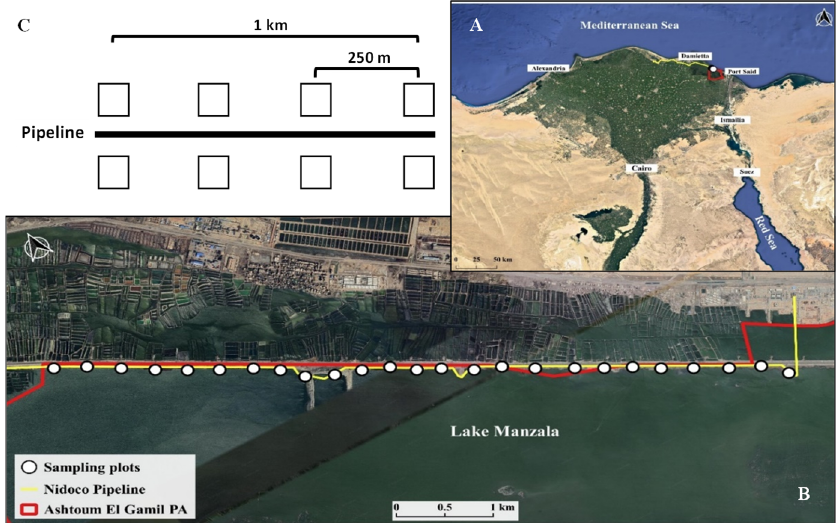
Figure 6. ( A ) Location of the study area showing the Ashtoum El-Gamil protected area, ( B ) the fifty sampling plots over the megaproject, and ( C ) the sampling scheme for the pre- and post-pipeline construction.